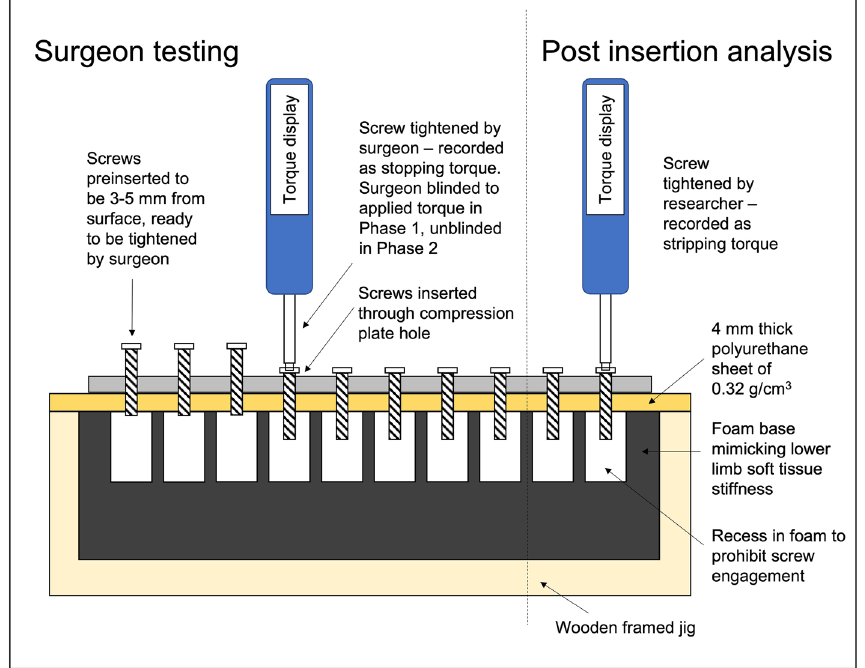
Figure 1. Diagram of testing arrangement showing screws pre-inserted to be 3–5 mm proud of the plate, to be tightened by the surgeon. Post insertion analysis performed at a separate